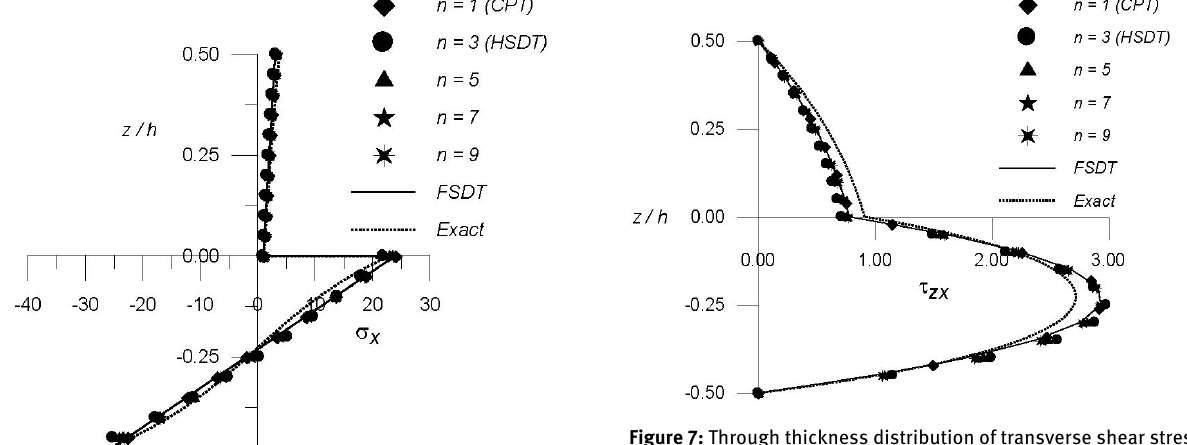
Figure 7: Through thickness distribution of transverse shear stress ( ¯ τ zx ) for simply supported two layered (0 ∘ /90 ∘ ) un-symmetrically laminated composite plates with a / h = 4 and E 1 / E 2 = 25